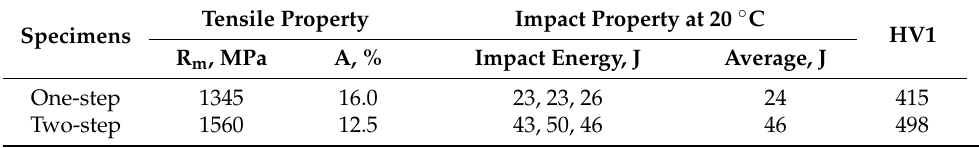
Table 3. Mechanical properties of the investigated